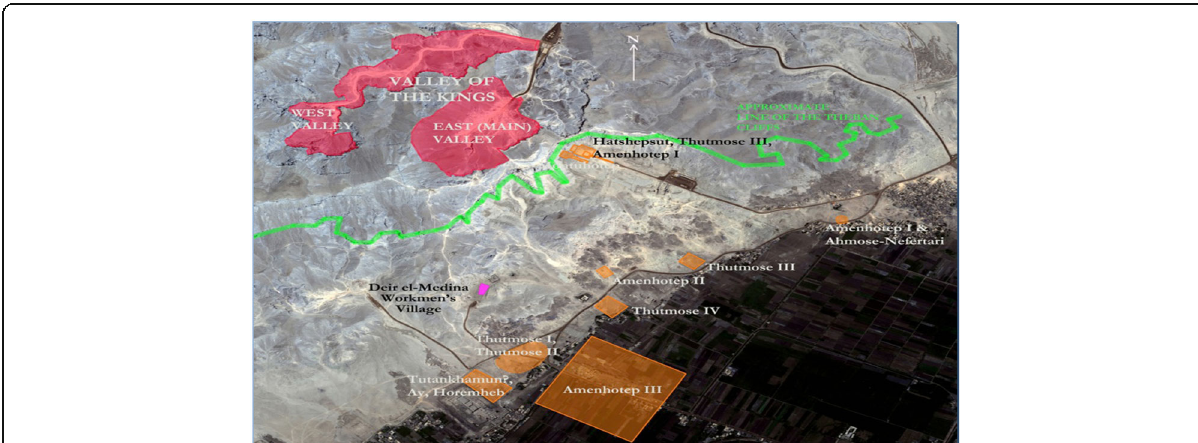
Fig. 1 Aerial photograph indicates the east (main) Valley of the Kings (KV) at Luxor Egypt. Modified after Google earth map. The tomb of Sons of Ramsses II (KV5) is located at the middle of the Valley of the Kings, East Valley, Thebes West Bank at Thebes. The Theban Mapping Project ’ s